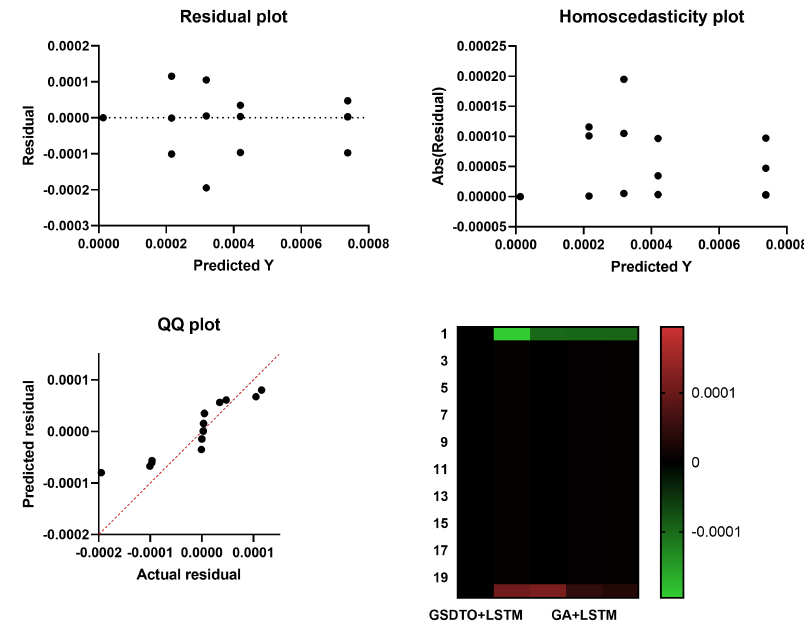
Figure 11. Residual, QQ, homoscedasticity plots, and heat map of the presented and compared algorithms based on LSTM